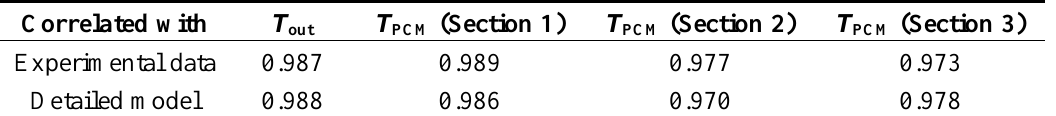
Table 1. Correlation coefficients between simplified model, experimental data and detailed simulation.